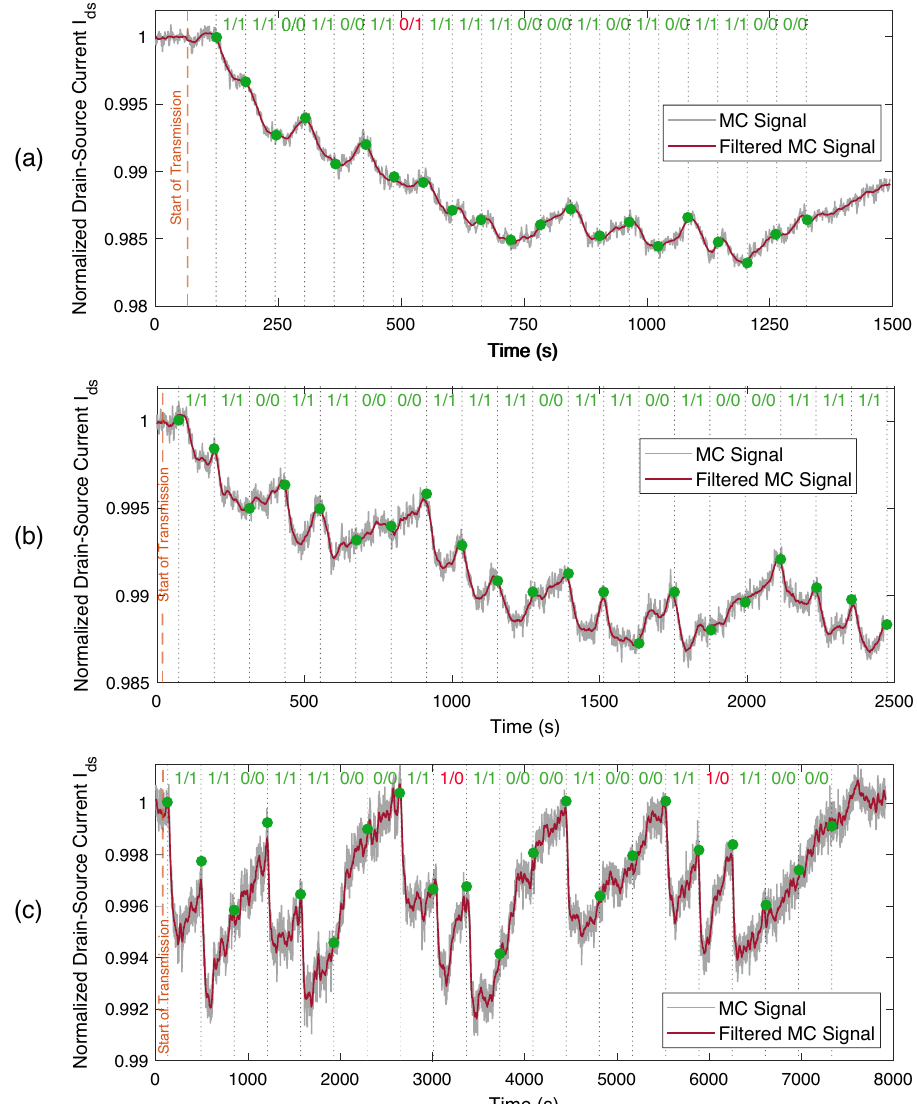
Figure 14. Delay-shifted version of the receiver response for binary data transmission for varying bit intervals: 60 s, ( b ) T 120 s, ( c ) T 360 s. Dashed orange line denotes the start time of the data transmission, ( a ) T s s = s = = and grey dashed lines demarcate the individual bit intervals. Green dots on the received MC signal indicates the sampled current values for difference-based detection method with the decoding rule formulated in (20). Transmitted/decoded bits are noted above each bit interval, with the red-coloured ones denoting the erroneously decoded